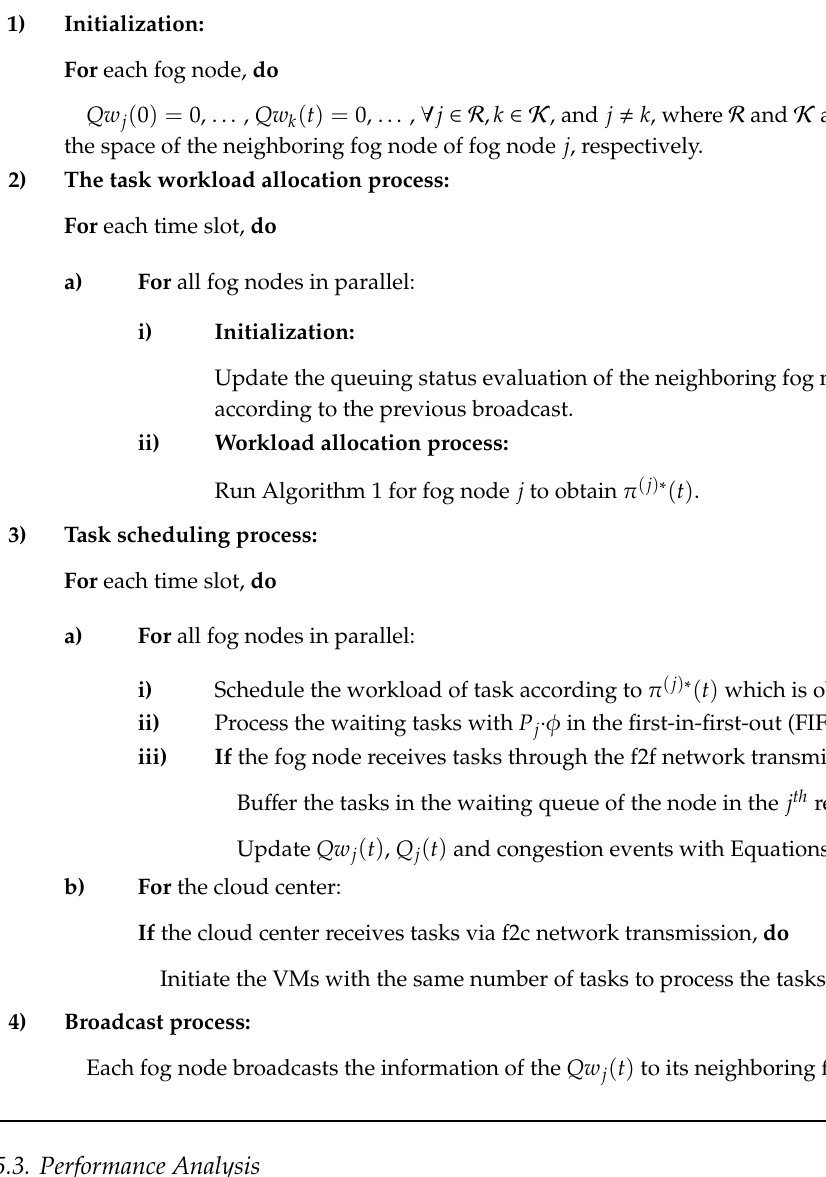
Algorithm 2 DAOWA-based workload allocation and task scheduling